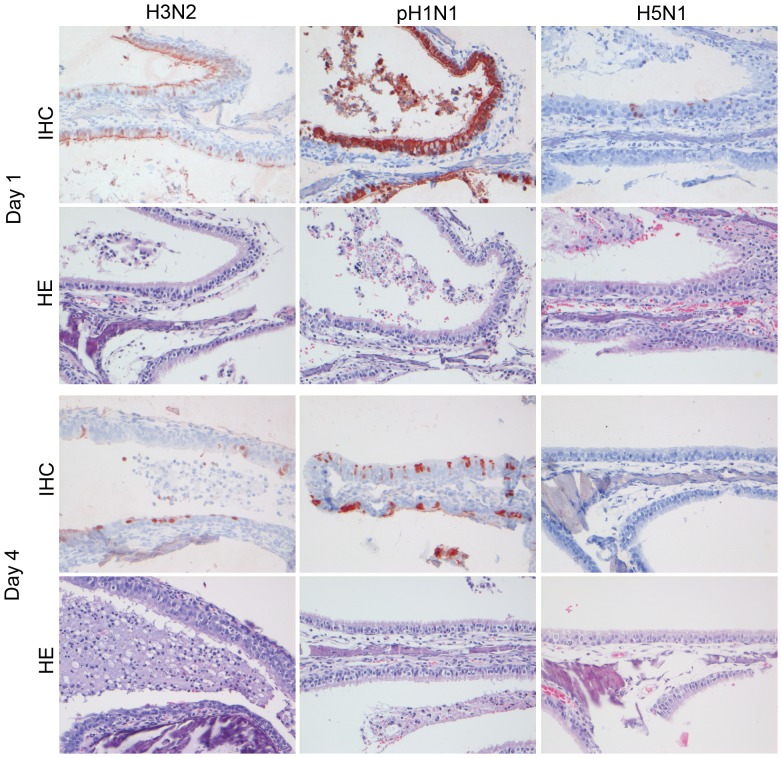
Antigen expression and histopathology of nasal respiratory epithelium of ferrets inoculated with different influenza viruses.There is high antigen expression with associated lesions characterized by neutrophilic rhinitis in the nasal respiratory epithelium of ferrets inoculated with H3N2 and pH1N1 on 1 dpi and lower expression on 4 dpi, while for H5N1 there is only occasional expression on 1 dpi. HE and immunoperoxidase counterstained with hematoxylin, 200×.